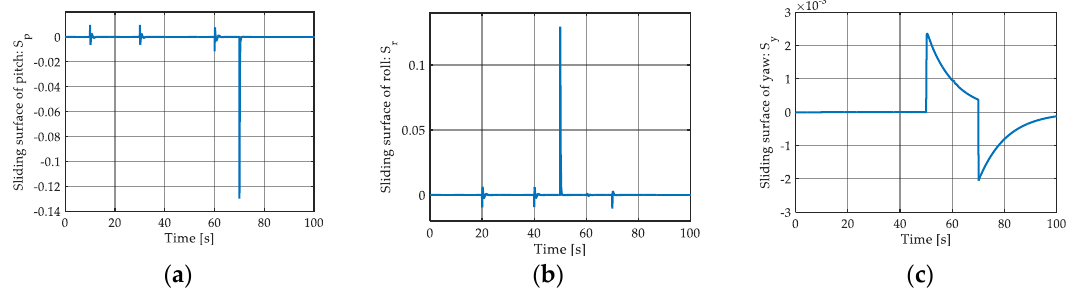
Figure 9. Sliding surface: ( a ) Pitch angle; ( b ) roll angle; ( c ) yaw angle.